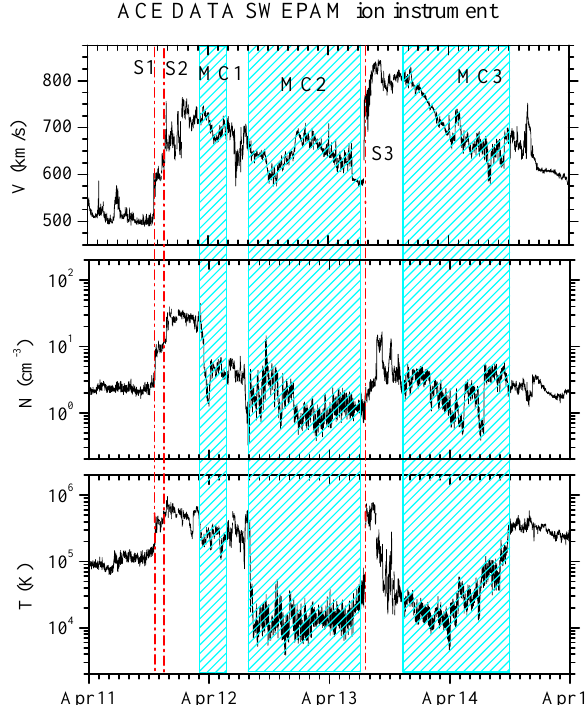
Fig. 1. Solar wind plasma observations of “multiple magnetic clouds” reported by Wang et al. (2003). The interval shows the in- teraction of three magnetic clouds and three interplanetary shock waves (data taken from the ACE SWEPAM (http://swepam.lanl.